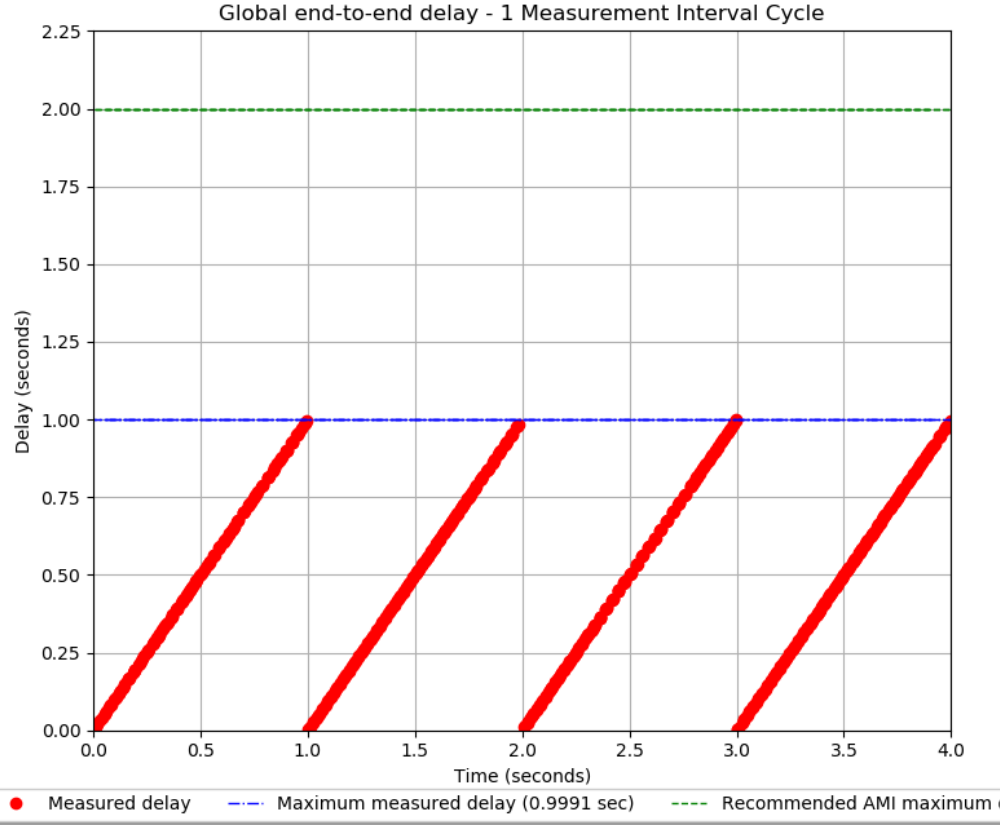
Figure 6. The global end-to-end delay during the one measurement cycle.